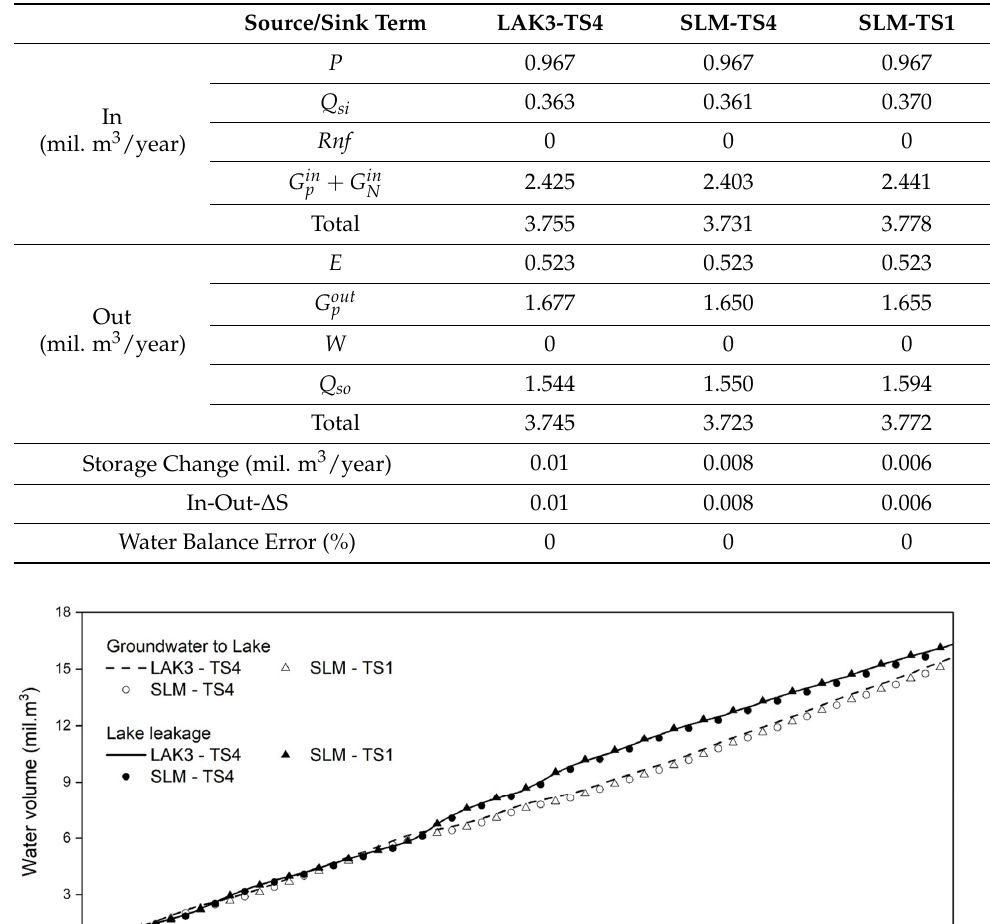
Table 3. Water balance for Lake Hampen in 2008.